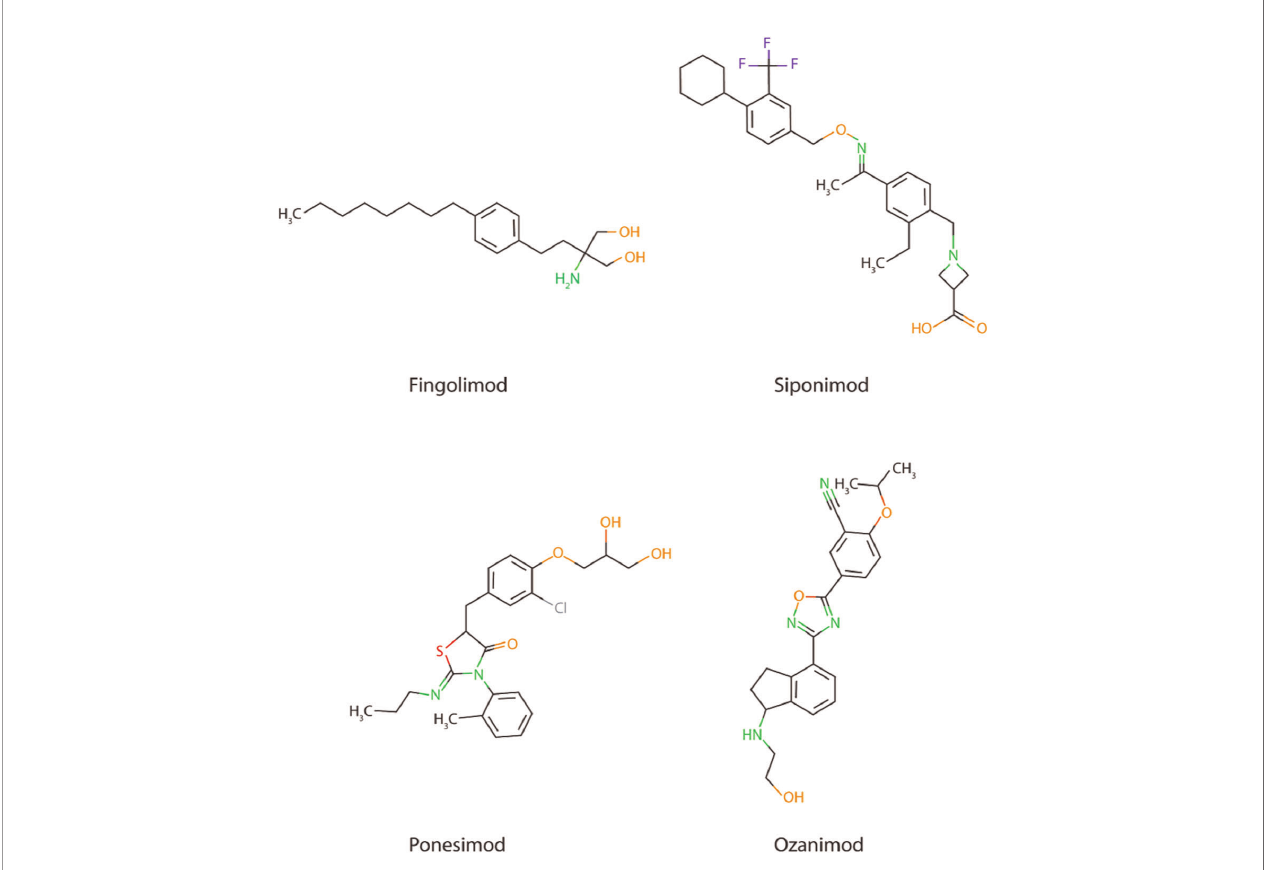
FIGURE 2 | Chemical structure of Fingolimod together with three other more selective S1PR inhibitors; Siponimod, Ponesimod, and